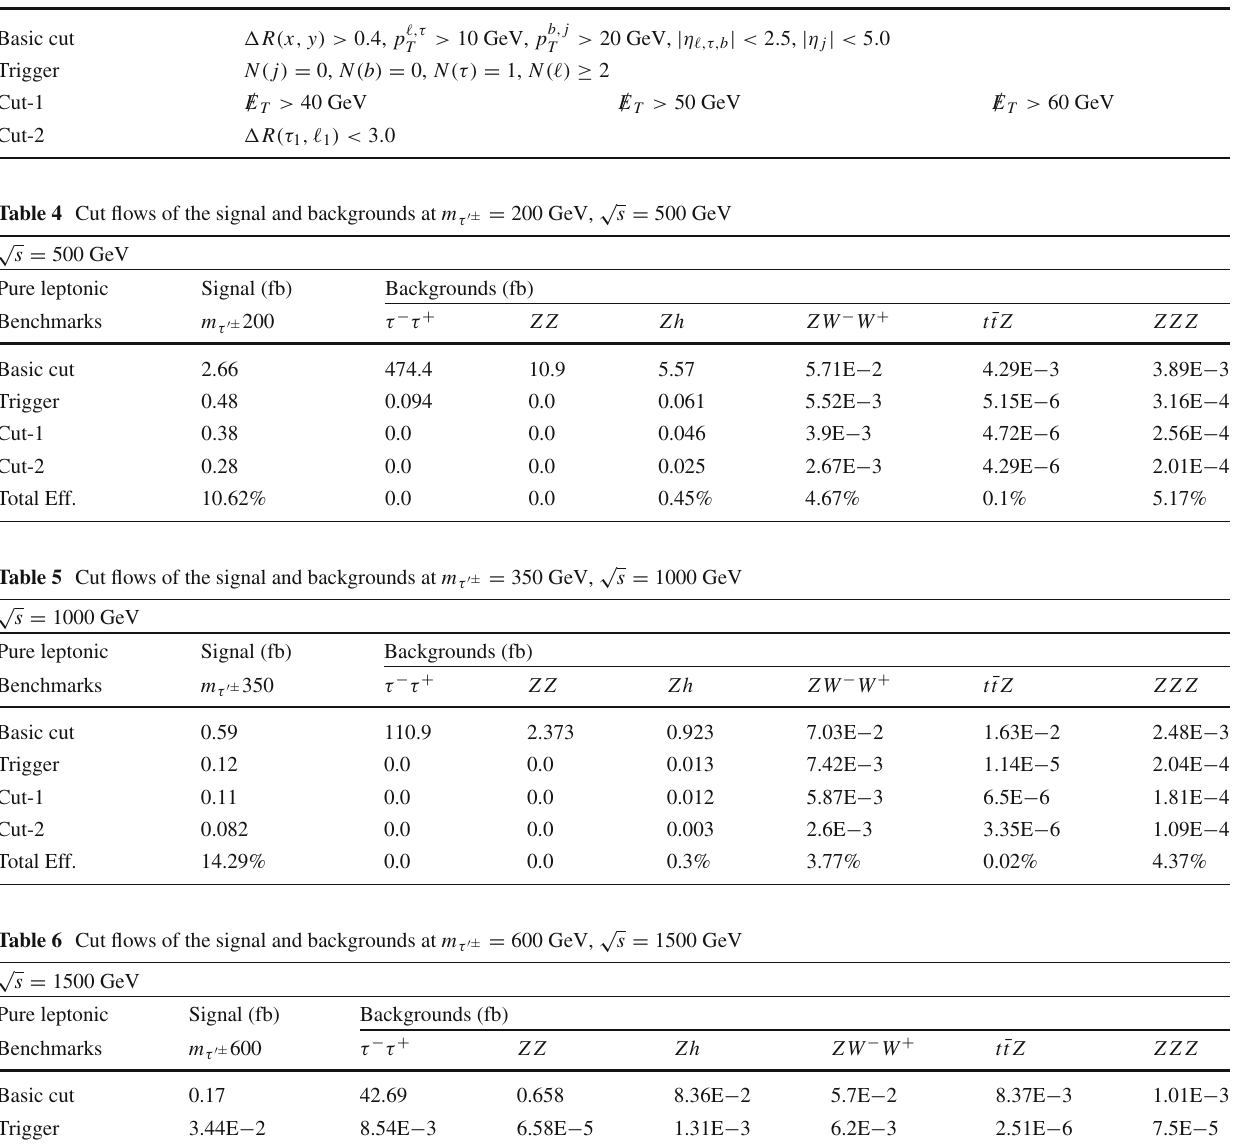
Table 3 Summary of the cut schemes, where τ stands for the τ -tagging jet, j = g , u , d , c , s stands for light flavour jets, b stands for the b -tagging jet, (cid:10) = e ,μ Pure leptonic